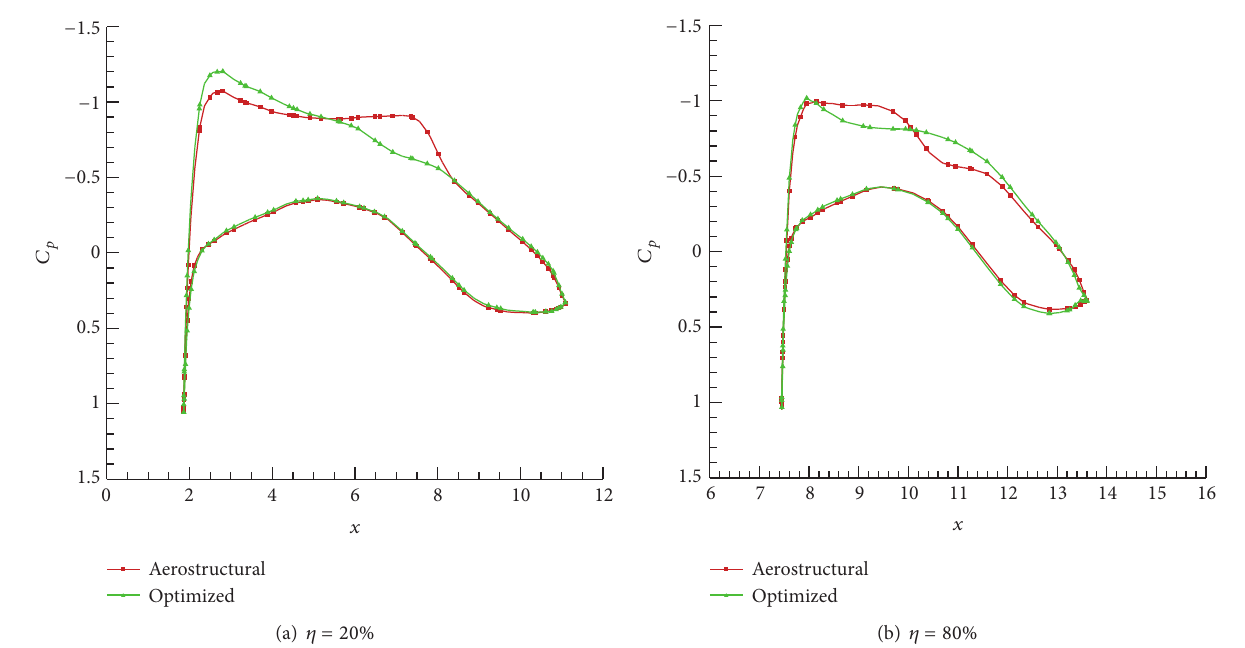
Figure 15: Comparison of section pressure coefficients before and after design of flexible